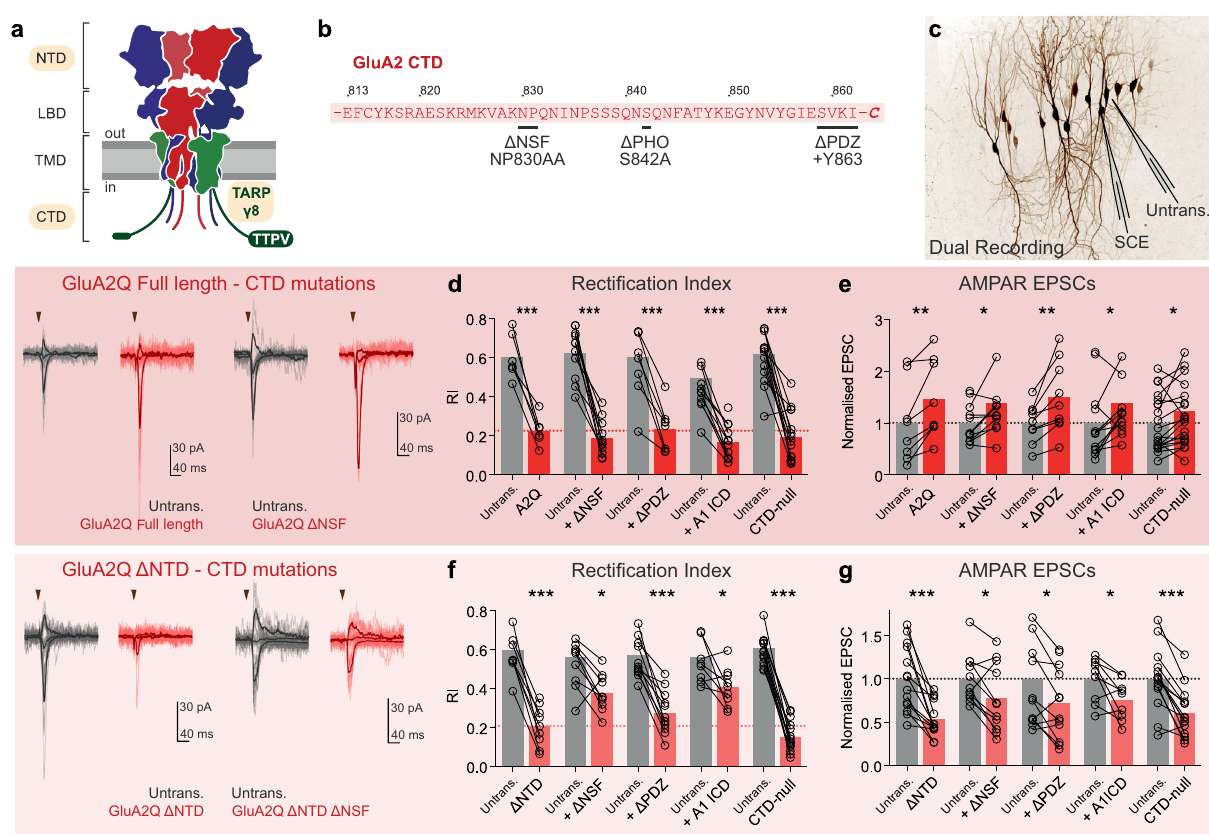
Fig. 1 GluA2 CTD-interactions exert a modulatory but nonessential in fl uence on receptor synaptic anchoring. a Schematic of heteromeric AMPAR architecture (blue - GluA1, red - GluA2) demonstrating the four domain layers (NTD - N-terminal or amino-terminal domain; LBD ligand-binding domain, TMD transmembrane domain, CTD C-terminal domain) and association with the auxiliary subunit TARP γ 8 (green), with the studied interaction domains highlighted yellow. b GluA2 CTD protein sequence with interaction mutations indicated. c Dual recording con fi guration involves simultaneous patch-clamp of untransfected (non fl uorescent, Untrans.) and single-cell electroporated (SCE) neurons, depicted on fl uorescence image of EGFP expressing CA1 neurons after SCE. d – e Dual synaptic recordings on GluA2Q construct expression. Full-length GluA2Q robustly reduces synaptic recti fi cation index d and increases AMPAR EPSC amplitudes e . No CTD modi fi cations altered this phenotype, demonstrating a nonessential role for this domain in synaptic receptor anchoring d – e . Example dual recordings (untransfected cell — Untrans., grey; transfected cell — red) for GluA2Q with (right) and without (left) Δ NSF mutation are depicted with individual sweeps (light) and average response (bold). Stimulation is indicated as a triangle. GluA2Q Δ NTD causes a robust reduction in the recti fi cation index of synaptic responses f and a reduction in AMPAR EPSC amplitudes g . These changes are partially alleviated by some GluA2Q CTD mutations such as NSF site mutagenesis ( Δ NSF) or GluA1 intracellular domain (ICD) exchange f – g . Prenormalised data are presented in Supplementary Figure 1f – g, and data values and statistical details are presented in Supplementary Table 1. Bars represent mean values, * indicates p < 0.05, ** p < 0.01 and *** p < 0.001. Source data are provided as a source data fi